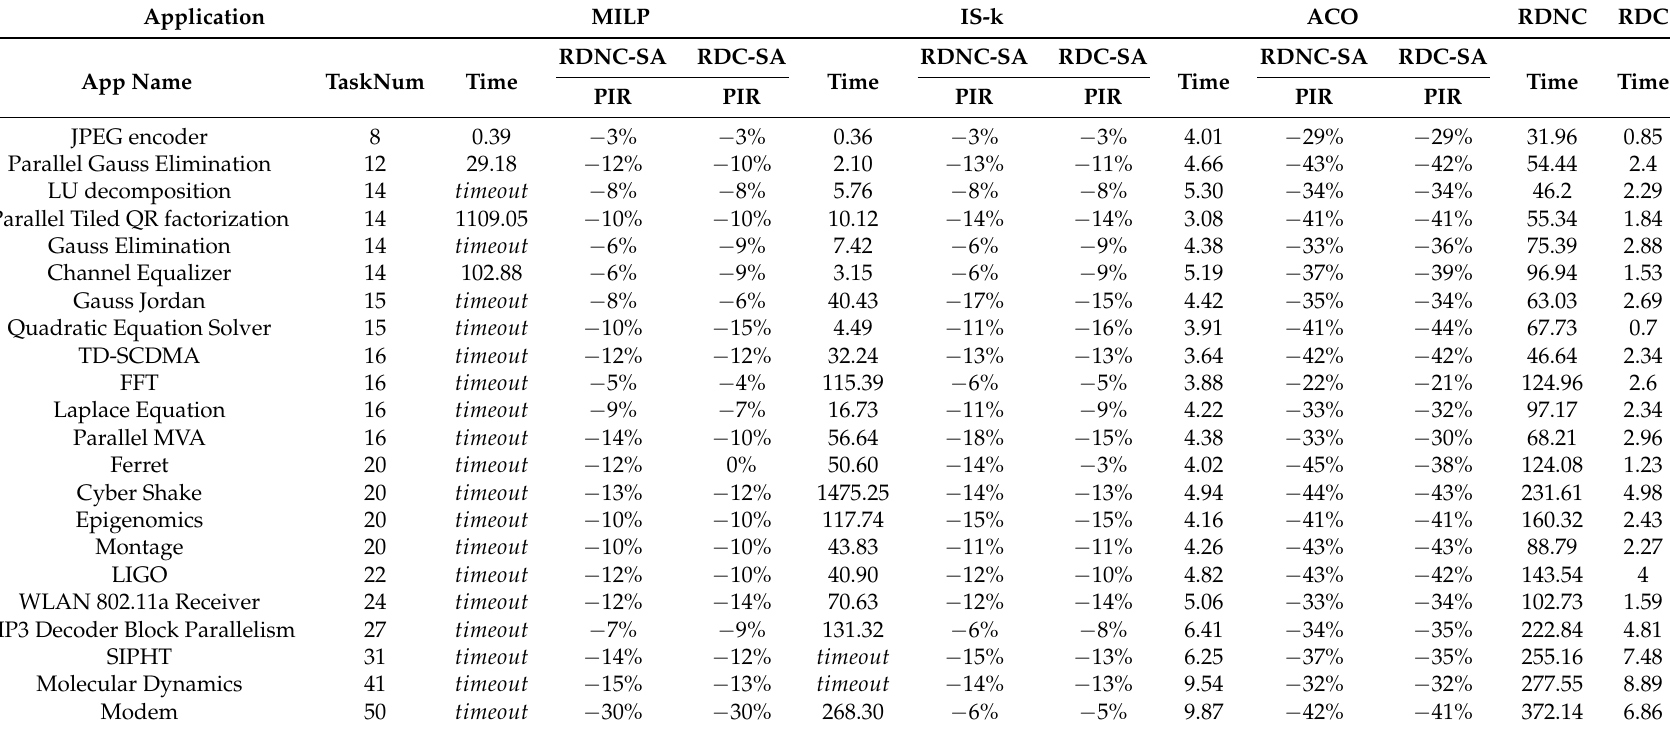
Table 2. Experiment result (resource ratio =